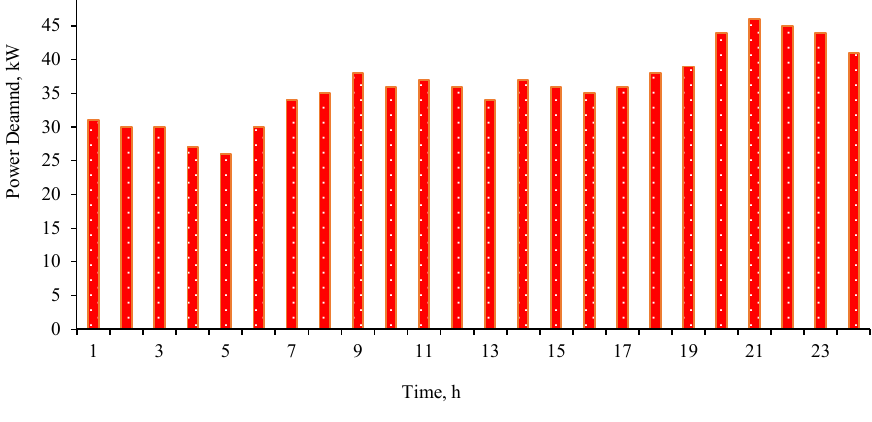
Fig. 2. Forecasted Load demand curve of the